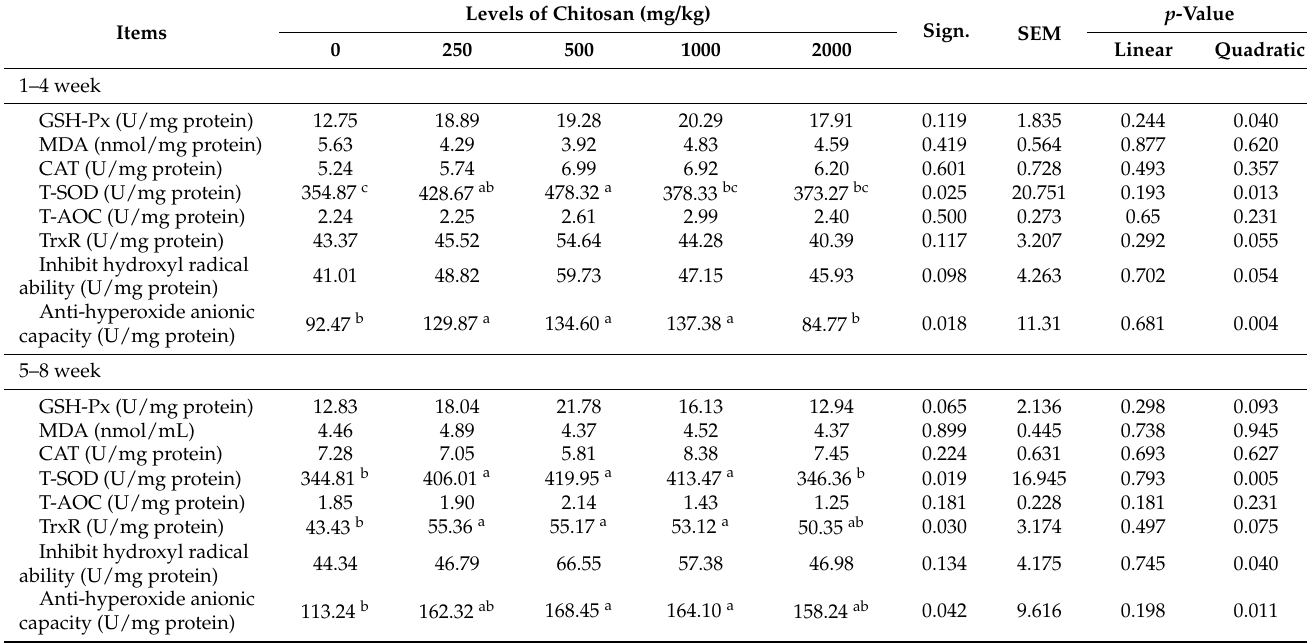
Table 7. Effect of dietary chitosan supplementation on duodenum antioxidant variables of laying breeders.